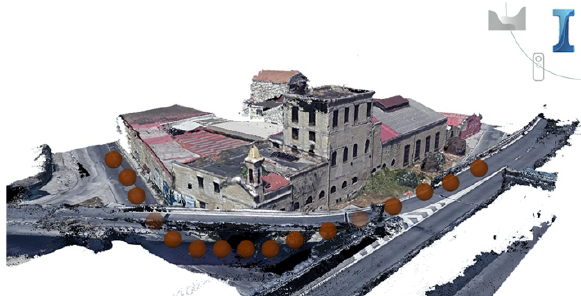
Figure 6 . Detail of the 3D model obtained with SFM algorithms applied to spherical images acquired by rapid mapping techniques (in red the acquisition